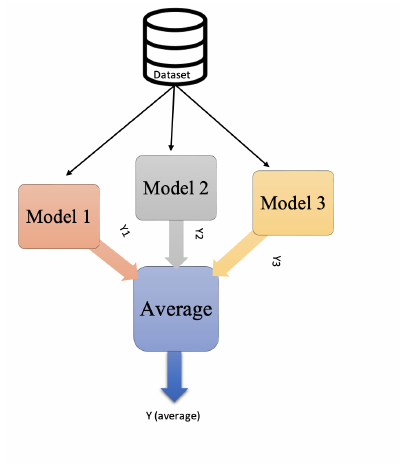
Figure 9. Average ensembles.